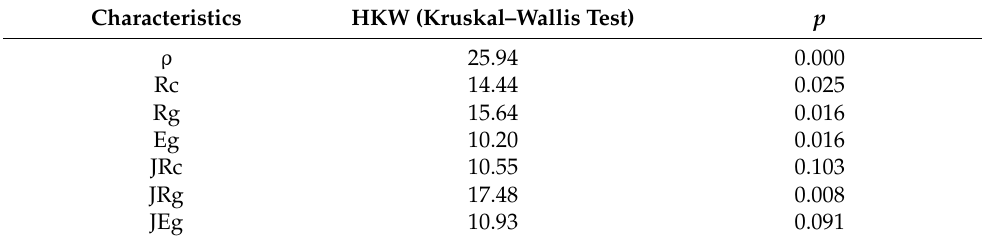
Table 8. Observed significance level of origins for some selected